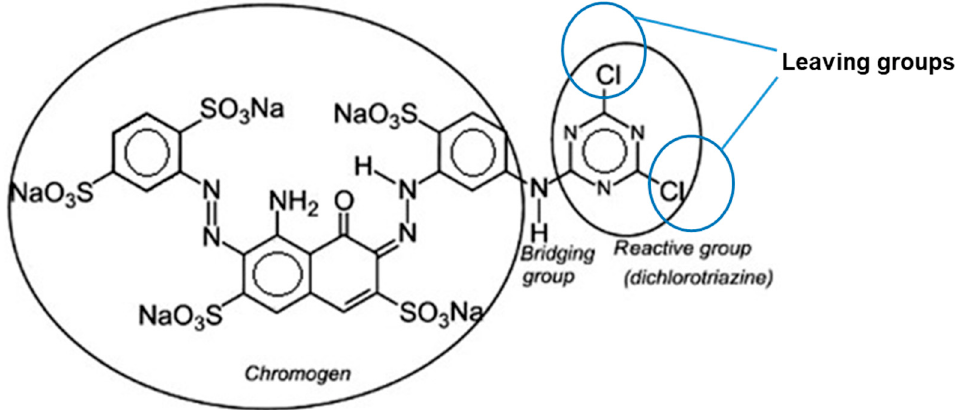
Figure 1. Chemical structure of CI Reactive Blue 109, a dichlorotriazines type reactive dye. (Adapted with permission from reference [29], Copyright 2017 Elsevier).